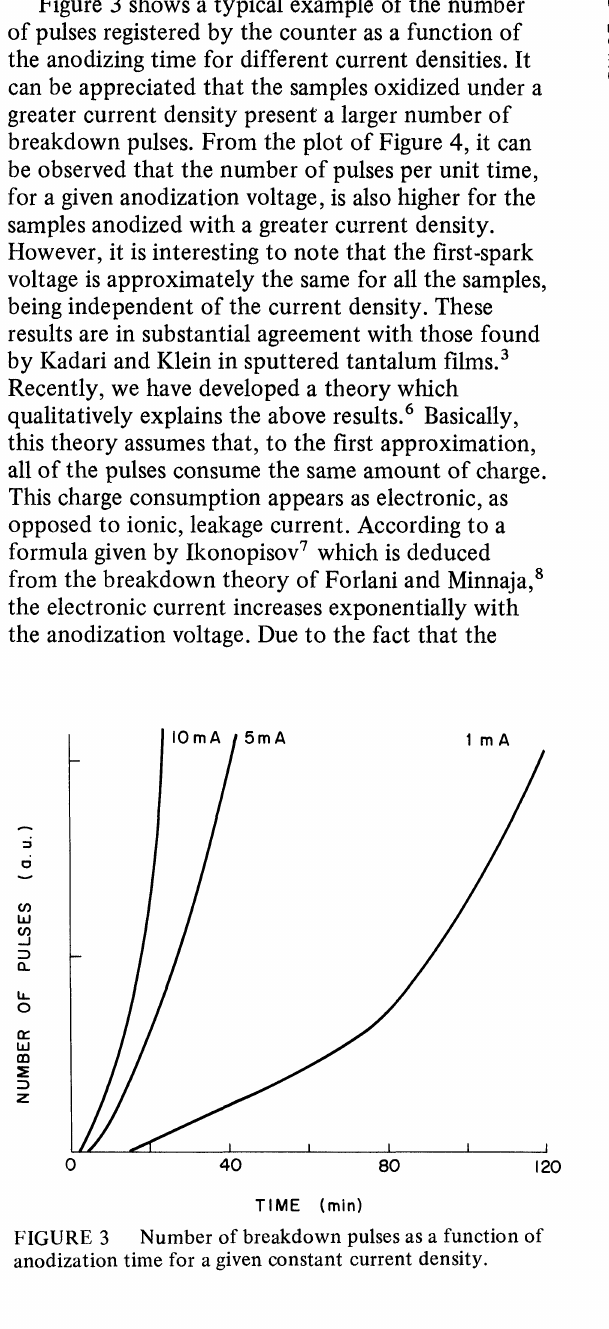
Number of breakdown pulses as a function of anodization time for a given constant current density.